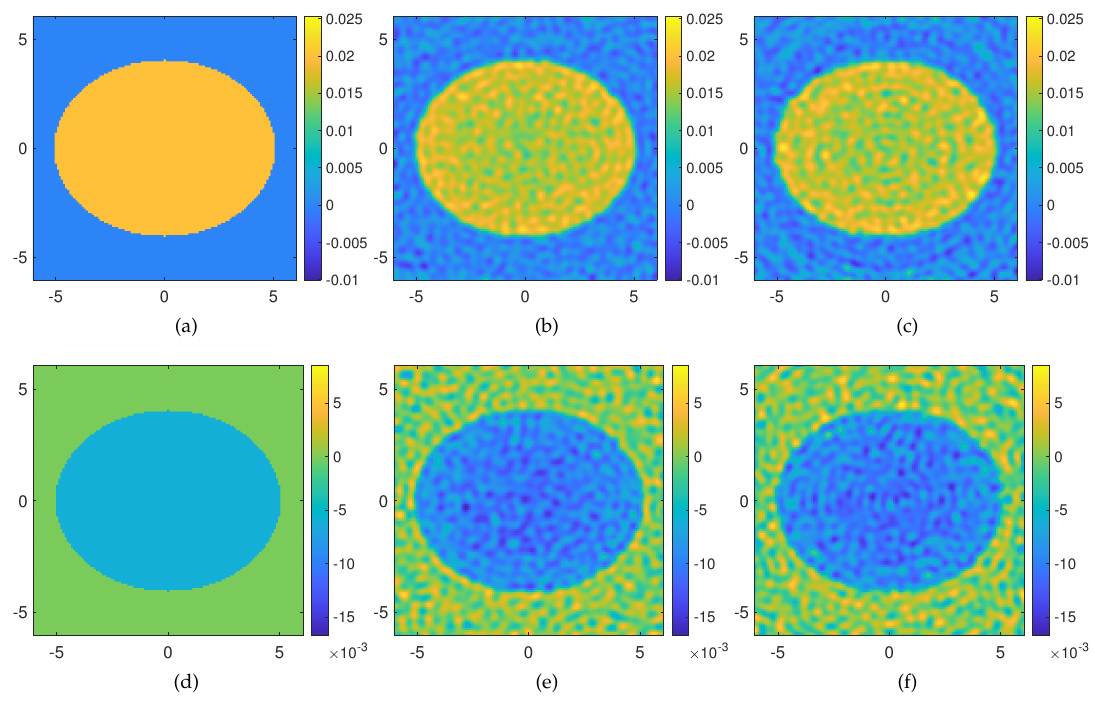
Figure 5. Reconstruction of a large circular scatterer through the Rytov approximation exploiting OAM fields generated in the far-field ( r m = 100) m and near-field ( r m = 9) m of the imaging domain. The OAM orders used are (cid:96) = 0, ± [ 1 − 35 ] . ( a ) Real and ( d ) imaginary part of the actual contrast profile; ( b ) real and ( e ) imaginary part of the retrieved contrast profile in the far-field measurement configuration, reconstruction err = 0.1108 with a cutoff value in the TSVD reconstruction N T = 1856; ( c ) real and ( f ) imaginary part of the retrieved contrast profile in the near-field measurement configuration, reconstruction err = 0.1267 with a cutoff value in the TSVD reconstruction N T = 1557. The axes of the imaging domain are expressed in background